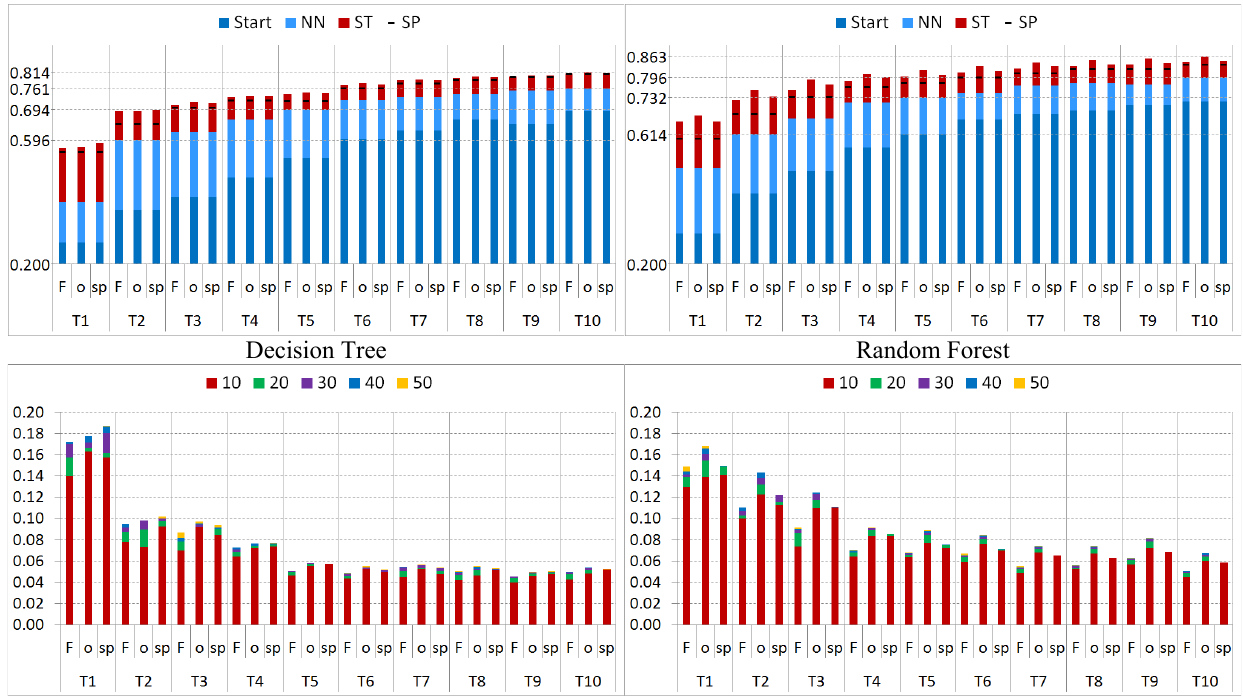
, using the i ), and sp (NH o sp